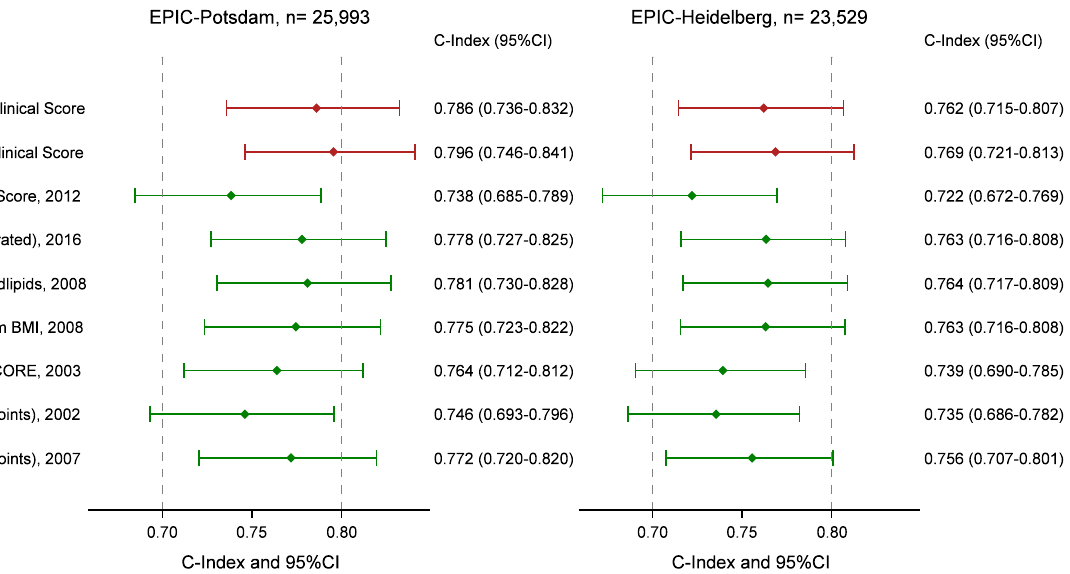
Figure 1. Discrimination of the developed scores and established CVD risk scores in EPIC-Potsdam and EPIC- Heidelberg. Discrimination is depicted as C -indices adjusted for competing risk analyses and 95% confidence intervals (95%CI). EPIC, European Prospective Investigation into Cancer and Nutrition. CMD, chronic metabolic disease. BMI, body mass index. MI, myocardial infarction. PCE, Pooled Cohort Equation. SCORE, Systematic Coronary Risk Evaluation.